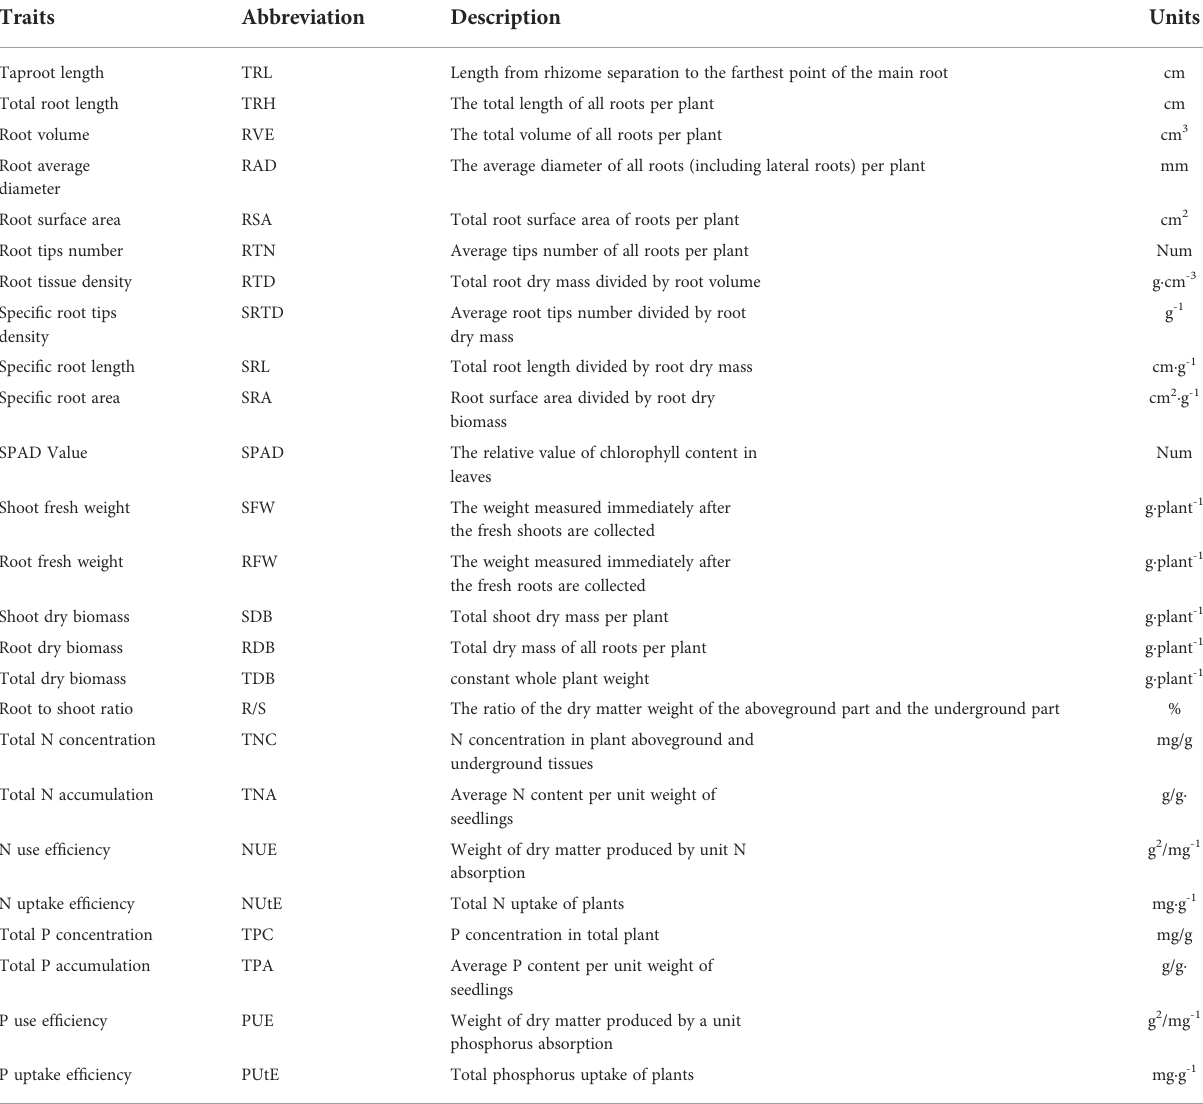
TABLE 1 Description of 25 measured morphological traits in 384 cotton genotypes.